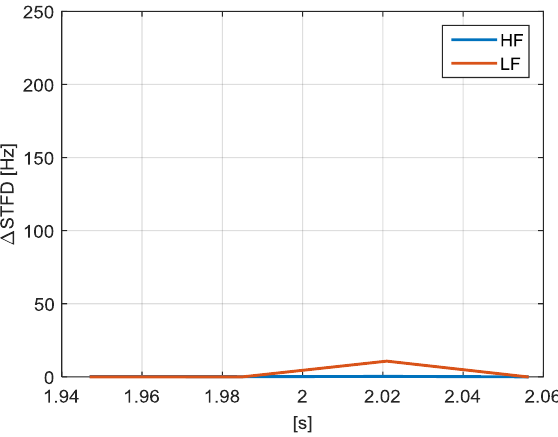
Figure 40. Case study 3: STDE at low-frequency (0 ÷ 2.4 kHz, red line) and at high-frequency (2.4 ÷ 150 kHz, blue line) obtained through Prony’s method.